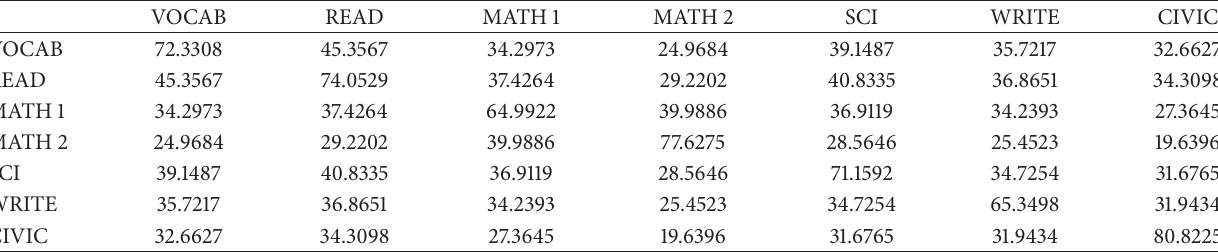
Table 5: Classical frequentist estimate for Σ